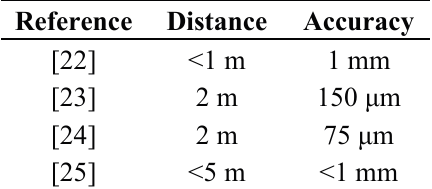
Table 1. Reported accuracy of FMCW radar based on the phase of beat signal.